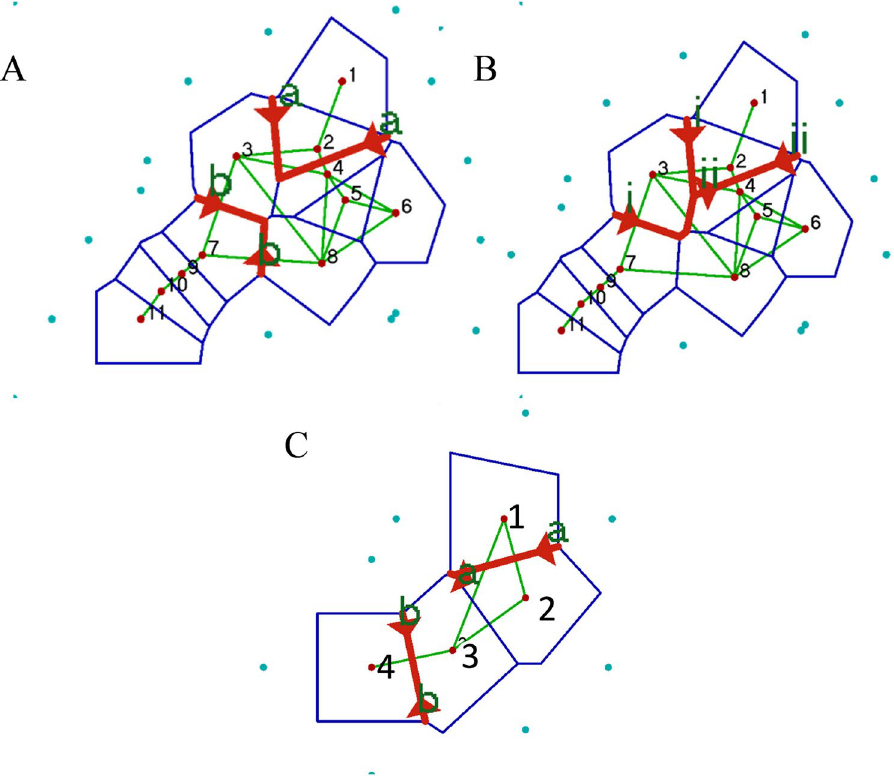
Figure 2. Predicted locations of genetic discontinuities (red lines) for Poecillastra laminaris populations based on COI variation ( A ) Cytb variation ( B ) and microsatellite variation ( C ) from Barriers software. Geomorphic populations were pooled in ( A , B ) 1–2 are Kermadec Ridge; 3 is Challenger Plateau; 4 is Hikurangi Margin, 5–6 are Chatham Rise; 8 is Campbell Plateau; 7–11 are Macquarie Ridge. In panel C, geomorphic population labelled 1 is Kermadec Ridge; 2 is Chatham Rise; 3 is Campbell Plateau, 4 is Macquarie Ridge.